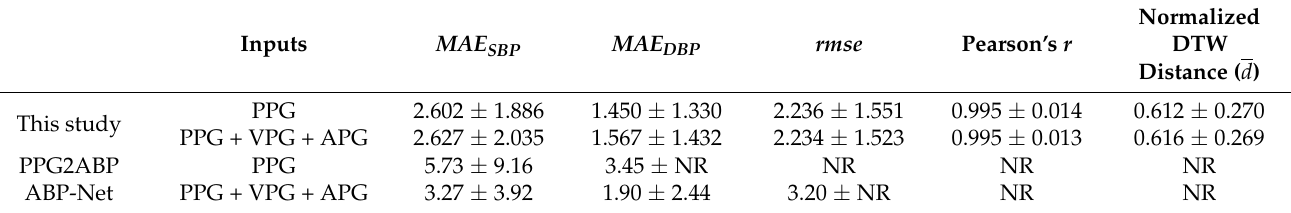
Table 2. Comparison of the performance of W-Net with those for existing methods in subject-specific model. The ’NR’ stands for not reported. Note that PPG = Photoplethysmogram, ABP = Arterial blood pressure, SBP = Systolic blood pressure, DBP = Diastolic blood pressure, and DTW = Dynamic time